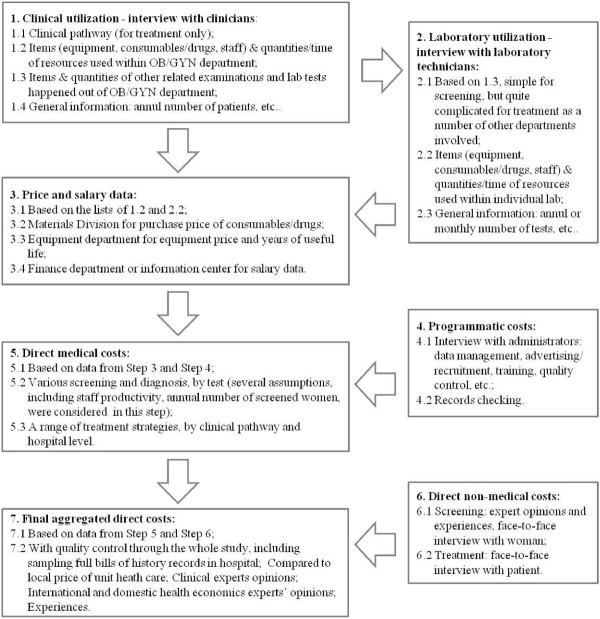
Workflow of costing study in Shanxi field†. † Study sites: The Women and Children Hospital of Xiangyuan County, and affiliated hospitals of Changzhi Medical College in Shanxi Province, 2008–2009.